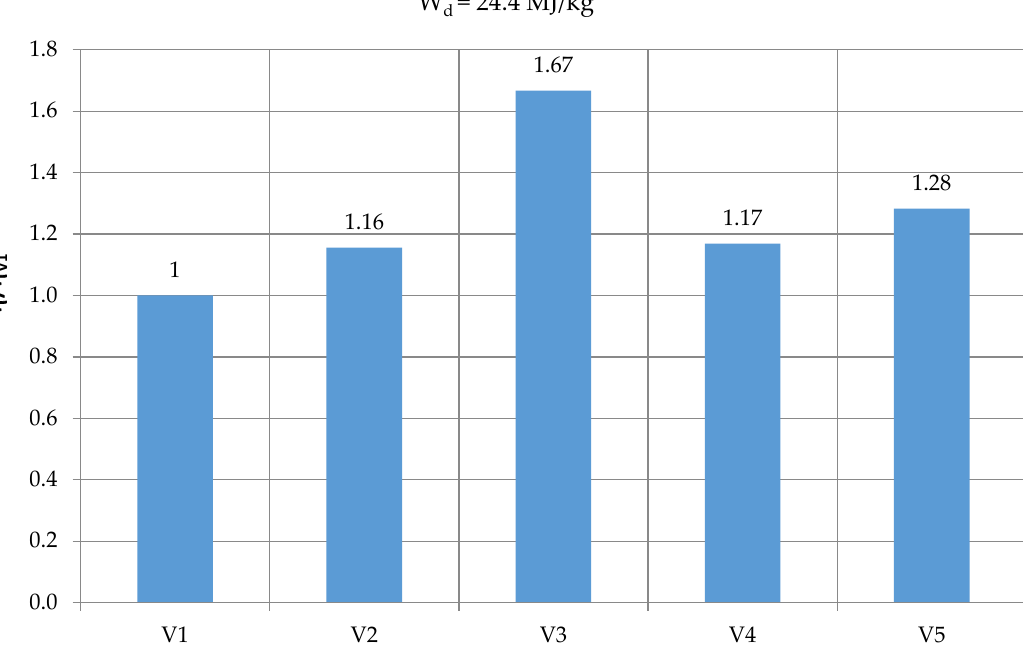
Figure 6. The e ff ect of the cycle structure on its as compared to variant 1 for heating value Figure 6. The effect of the cycle structure on its as compared to variant 1 for heating value W d = 17.5 MJ/kg. W d = 17.5 MJ / kg.